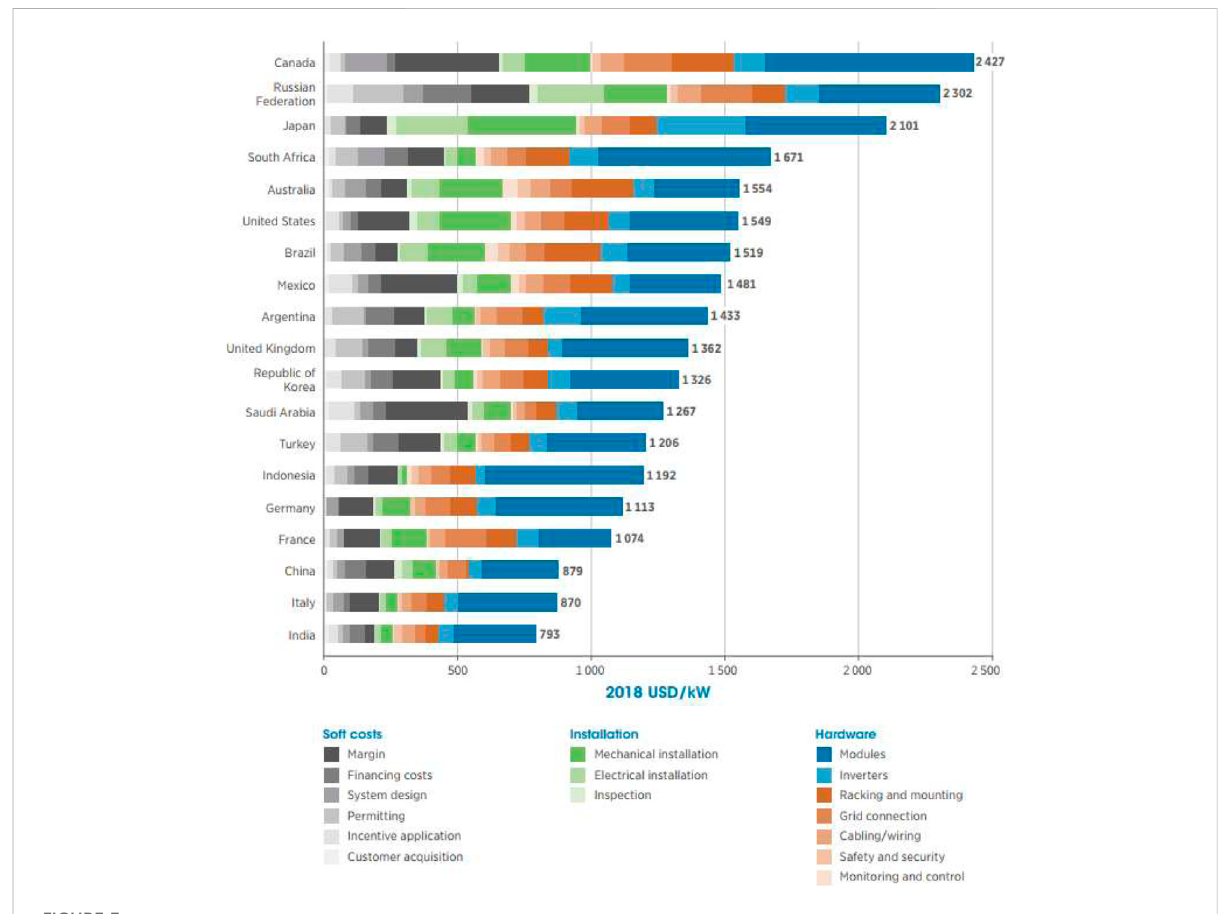
FIGURE 3 Renewable farm installation cost breakdown (IRENA,